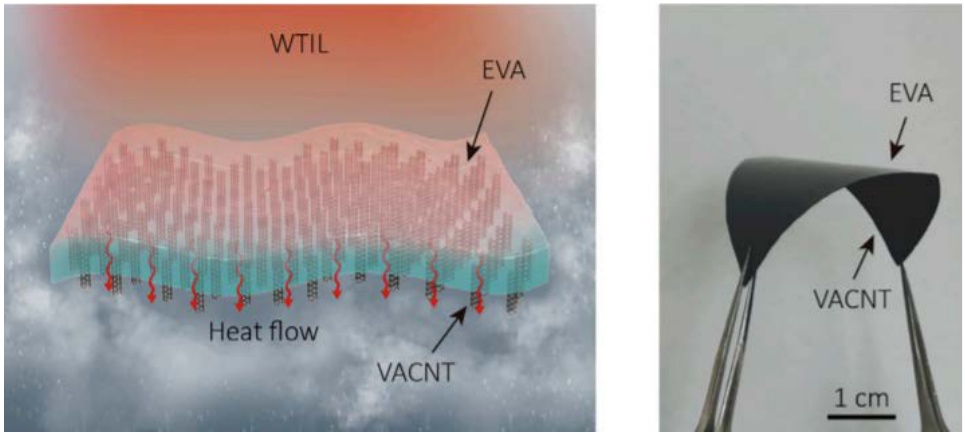
Figure 10. Schematic of synergistic tandem solar electricity–water generator and photograph of the VACNT-embedded ethylene vinyl acetate membrane [135] .